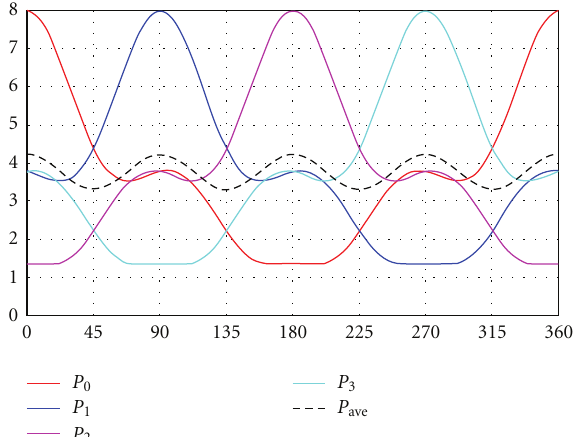
Figure 5: The powers P0, P1, P2 , and P3 delivered by the outputs of the MIPMOP amplifier shown in Figure 3 (in μ W) and the average power as a function of the azimuth (in degree) when the antenna array receives an incident plane wave of 1V/m